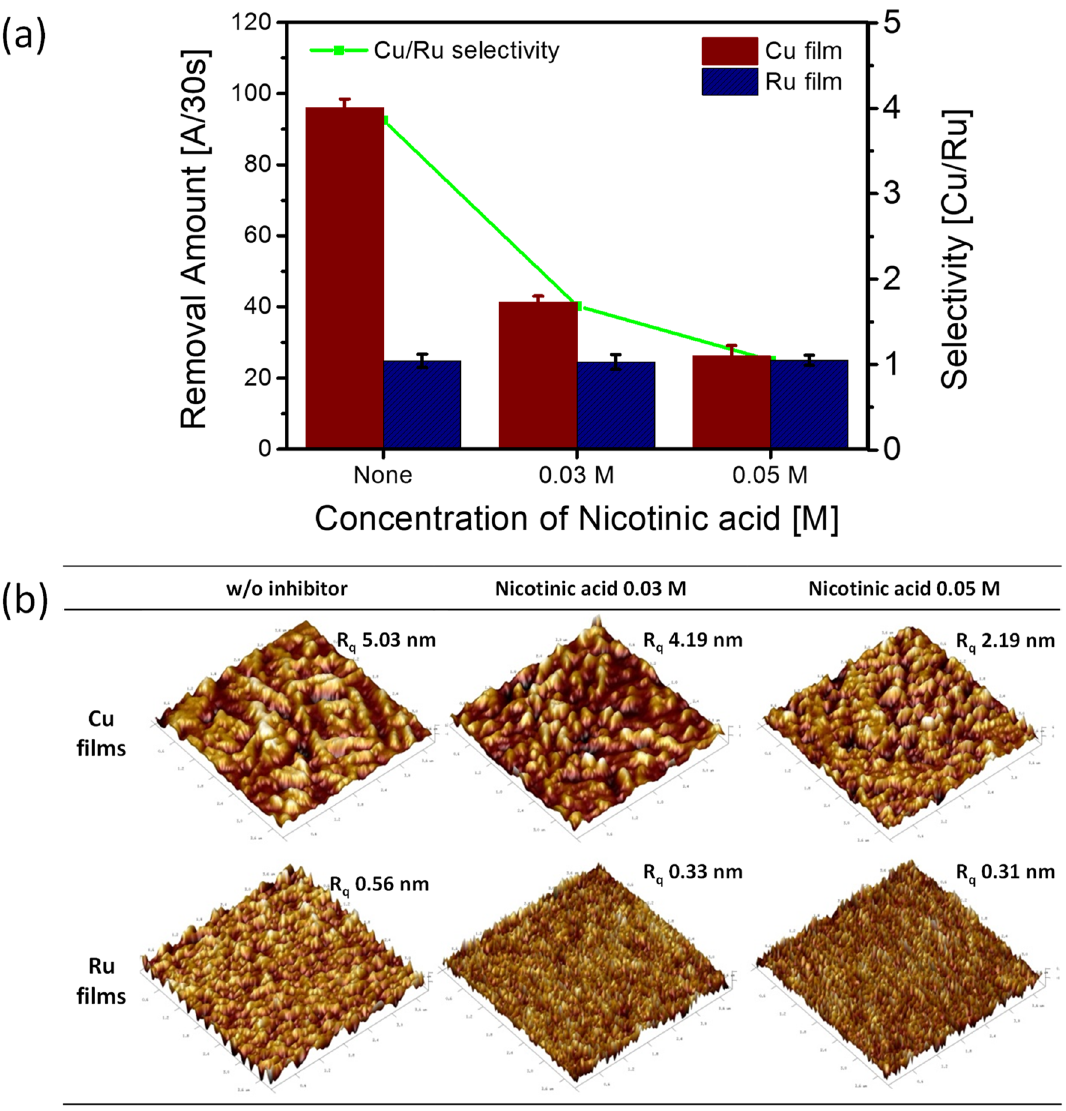
Figure 5. CMP performance for Cu and Ru films as a function of inhibitor concentrations at pH 10. (a) The removal rate of the metal film via nicotinic acid concentration. (b) The surface morphologies of metal films on the surface under different nicotinic acid concentrations through AFM measurement.